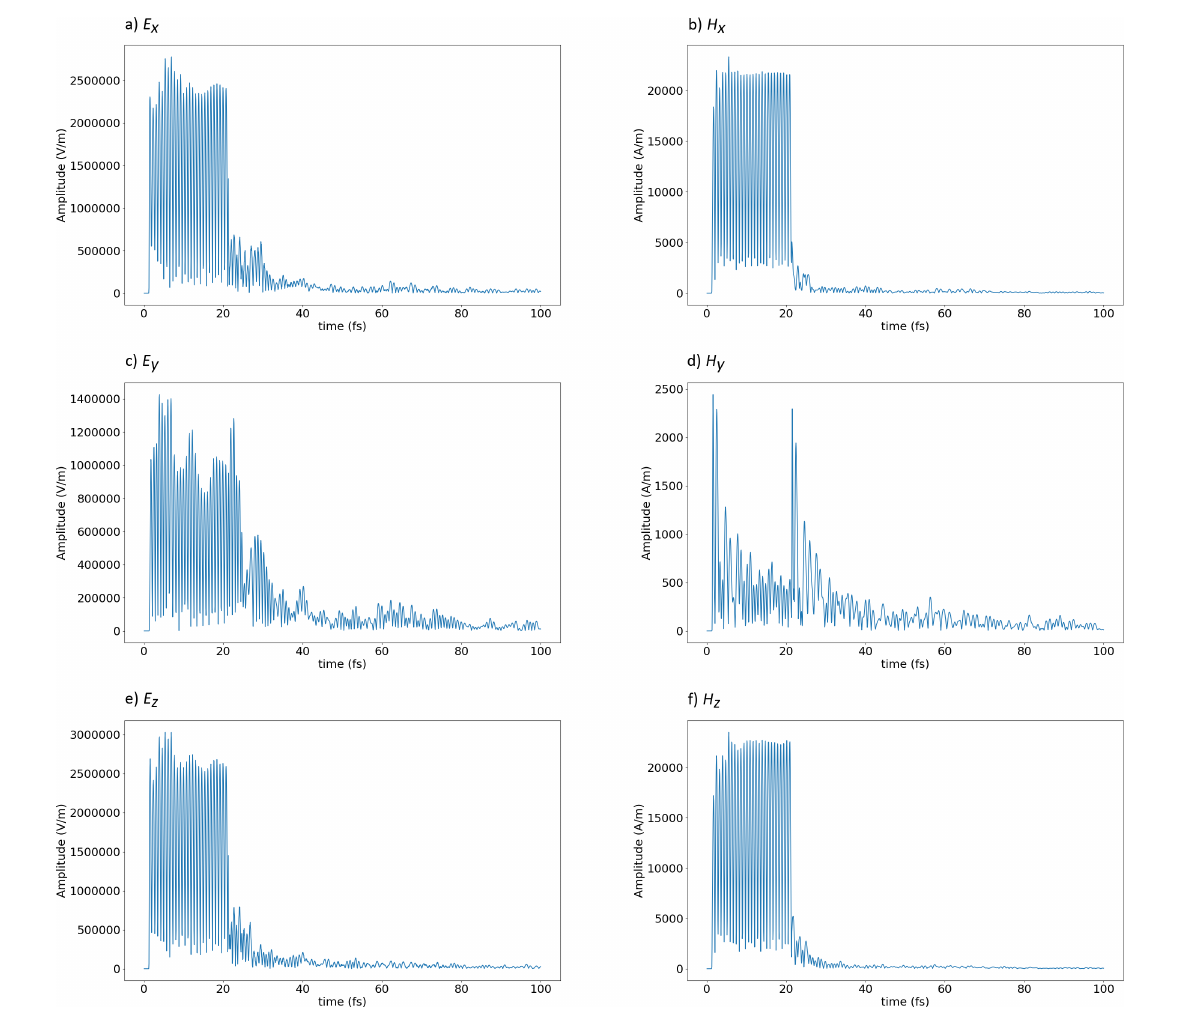
Figure 15: Calculated amplitudes of the components of the electromagnetic field as a function of the time, at the middle of the sample. The incident light at wavelength 460 nm is unpolarized. From (a) to (f): E x , H x , E y , H y , E z and H z .